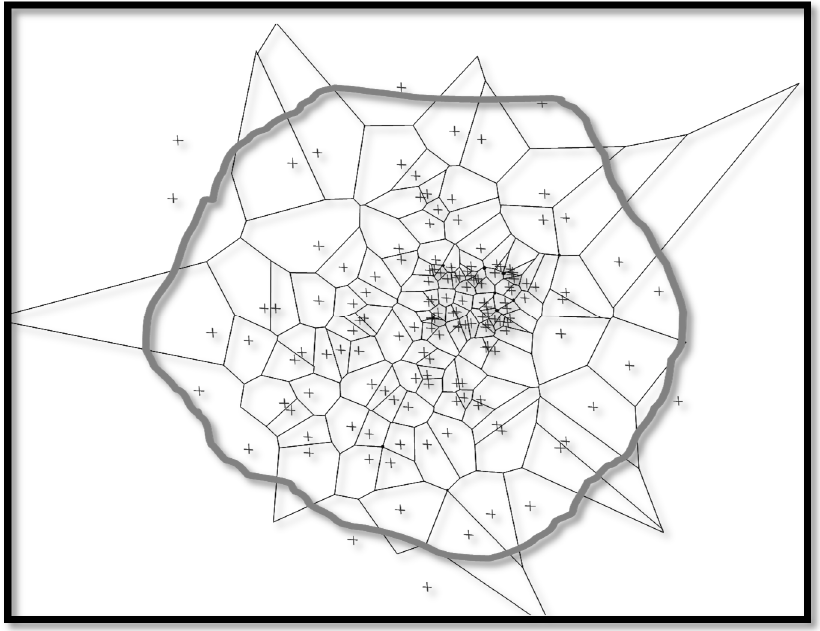
Figure 4. Target dataset regions and Voronoi polygons and the threshold perimeter for OCSOM. Target data defined by the threshold are resident inside the grey border line.